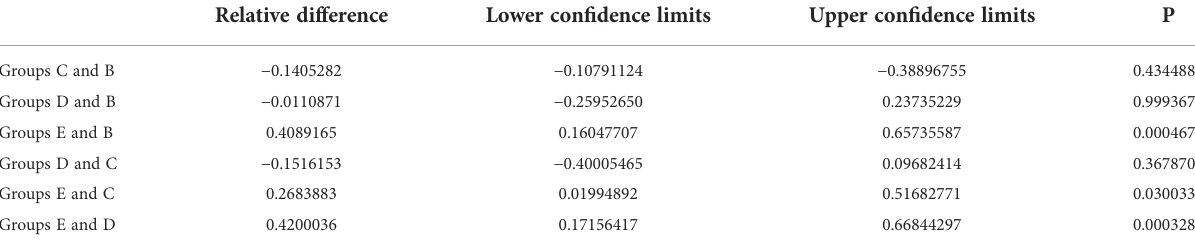
TABLE 6 Results of pairwise comparison of spleen index among